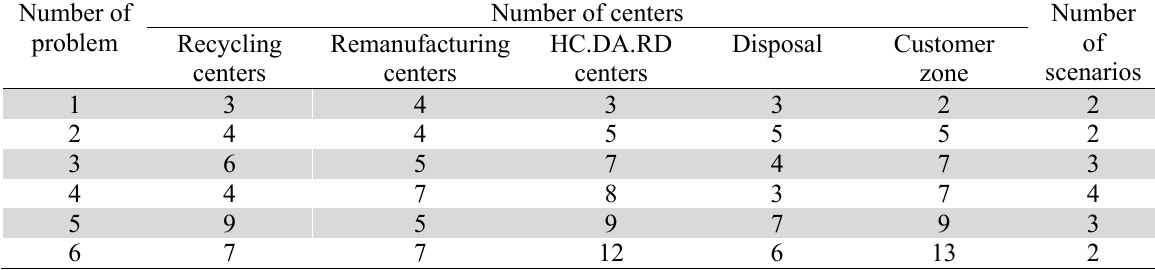
Number of centers Number